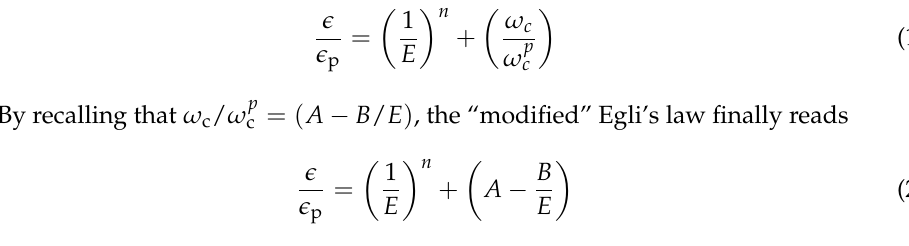
Figure 5. ( a ) DSC curves for a printed and foamed/printed PLA strand; ( b ) effect of expansion ratio on the crystallinity content—the dashed line is a guide for the eye.